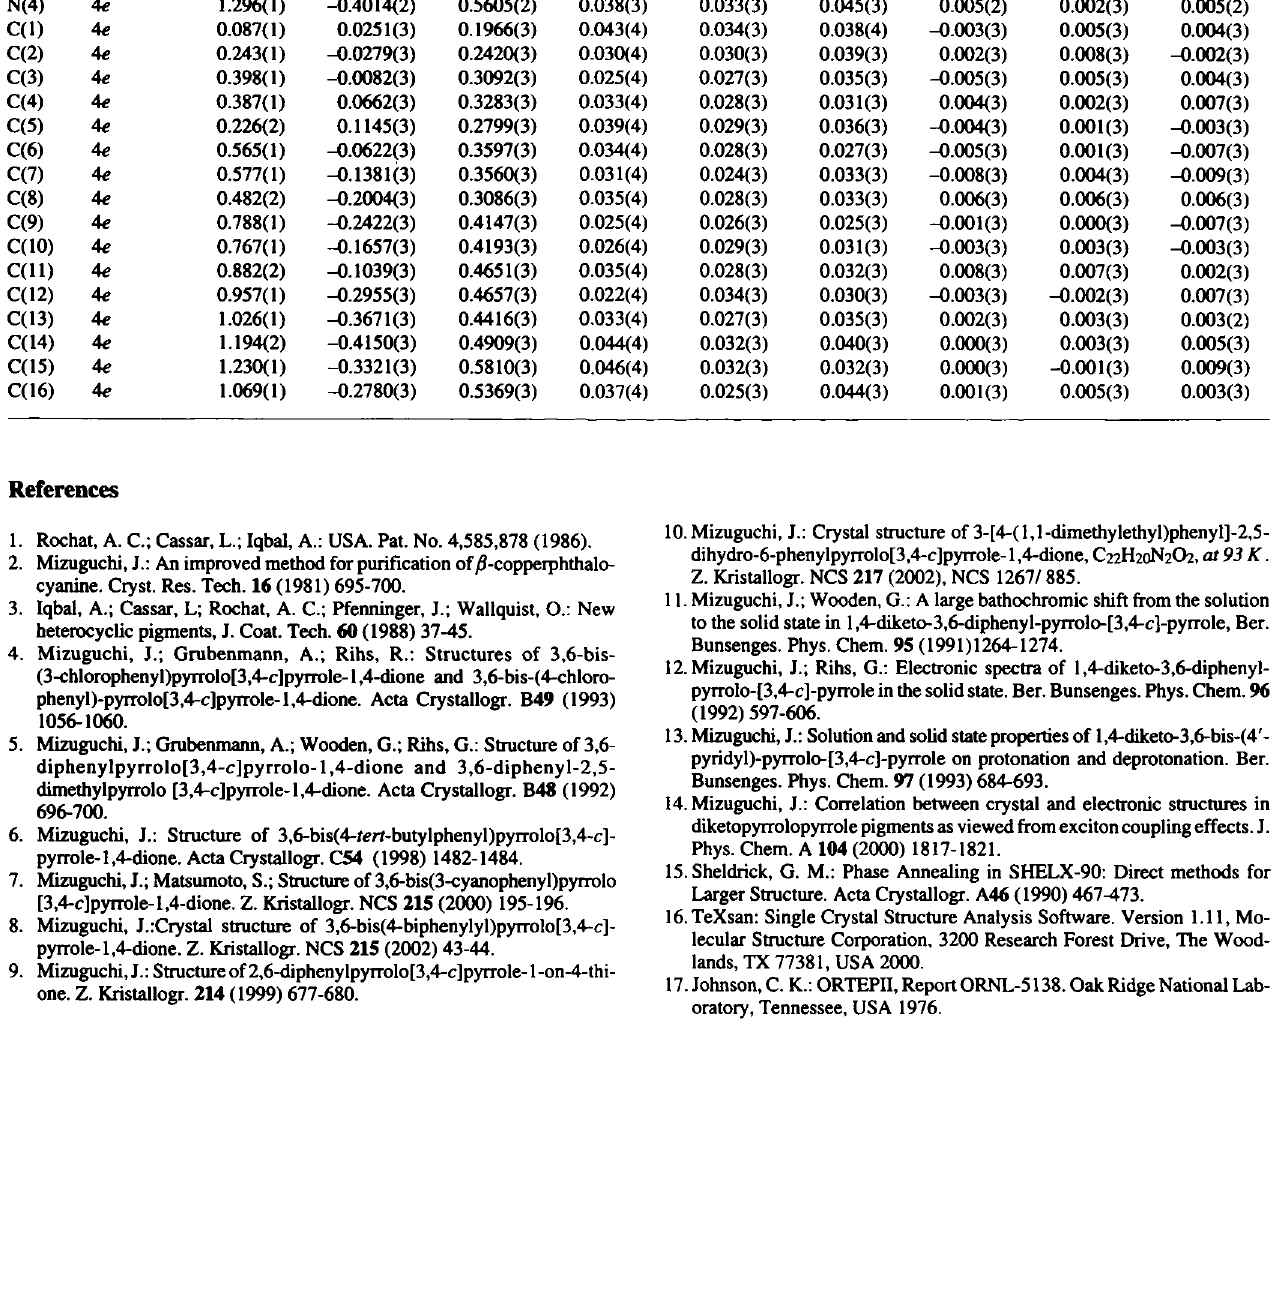
Table 3. Atomic coordinates and displacement parameters (in